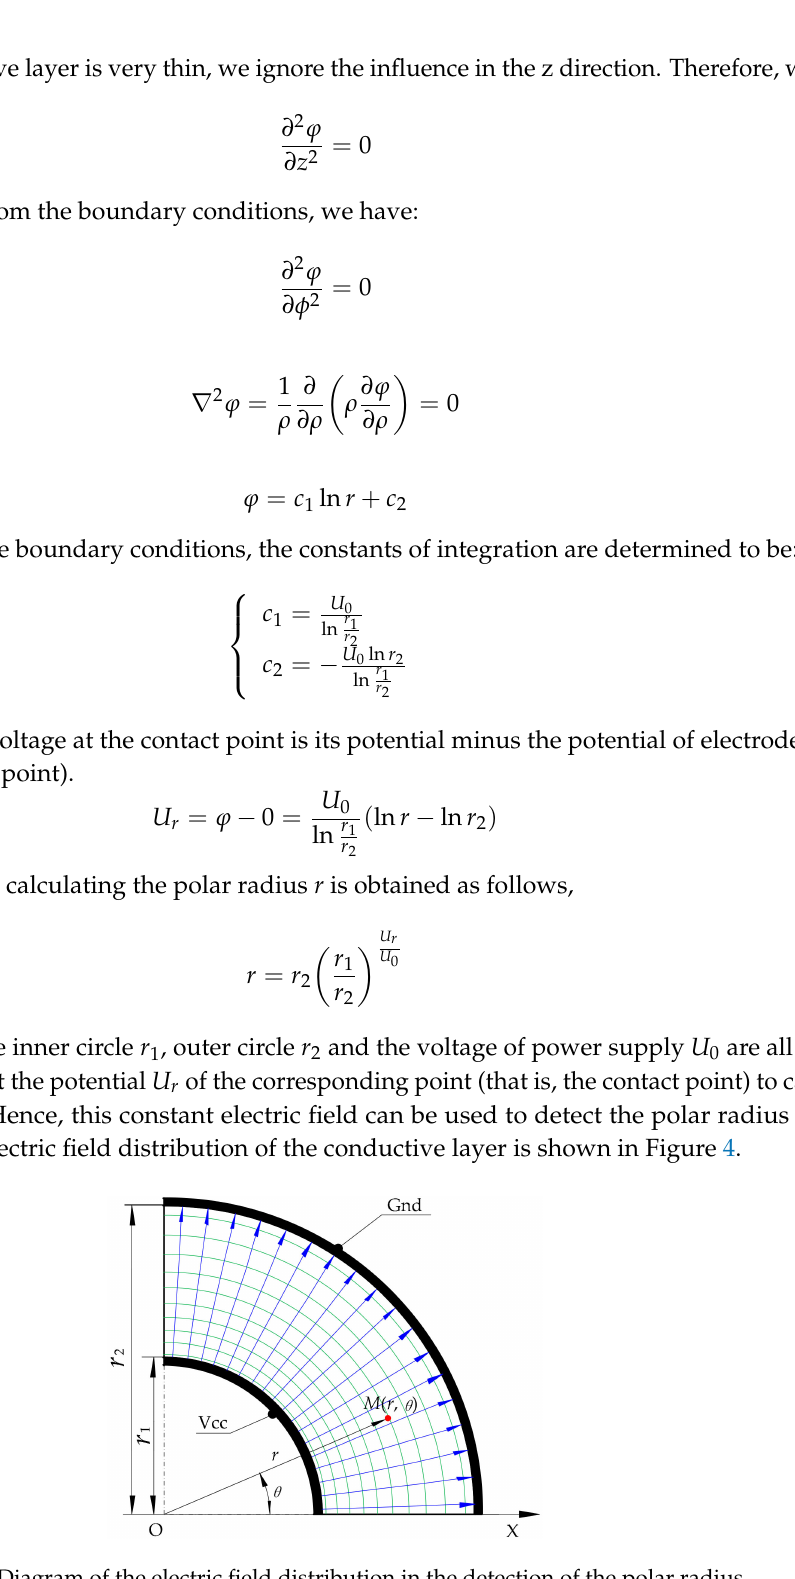
Figure 4. Diagram of the electric field distribution in the detection of the polar